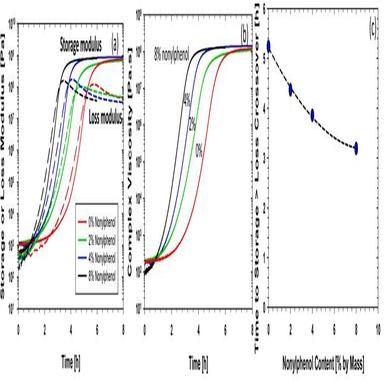
Storage (solid lines) and loss (dashed lines) modulus (a), complex viscosity (b), as a function of cure time at room temperature and the time to modulus crossover as a function of nonylphenol content (c), for the Epon 828/MXD system with varying amounts of nonylphenol accelerant.